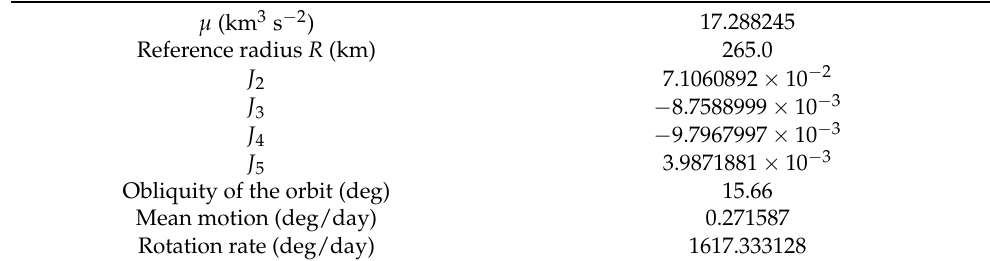
Table 1. The basic parameters of